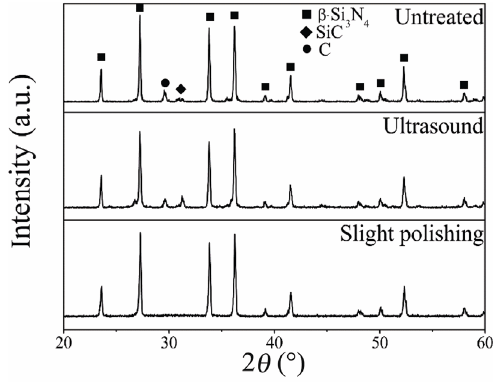
Fig. 3 XRD spectra of the sintered membranes.